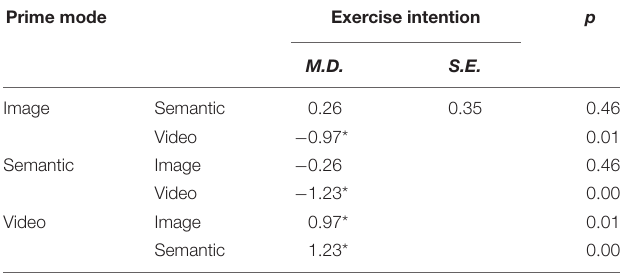
TABLE 3 | Multiple comparisons of one-way